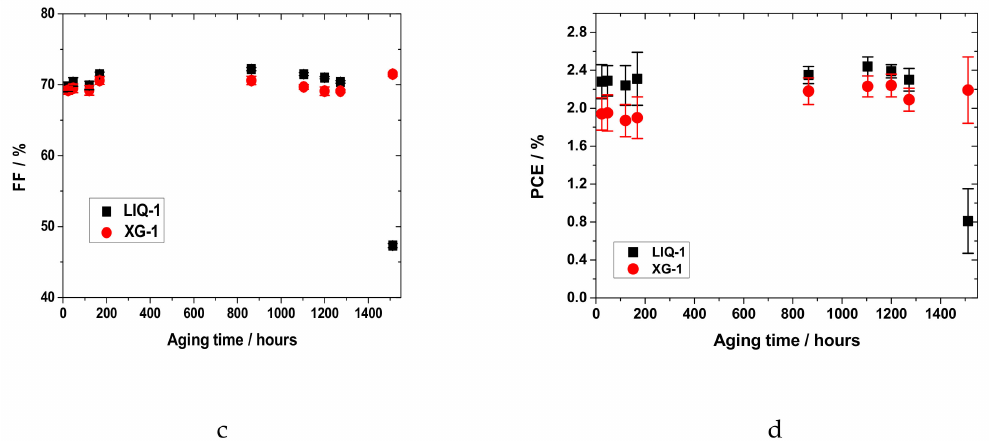
Figure 2. Best photovoltaic performance ( a ) V OC (voltage at open circuit); ( b ) J SC (short circuit current); ( c ) FF (fill factor); ( d ) PCE (power conversion e ffi ciency); and relative errors over time for aqueous liquid (black squares) and hydrogel (red circles) dye-sensitized solar cells (DSSCs). Data points refer to the third of three consecutive measurements at 1 sun.